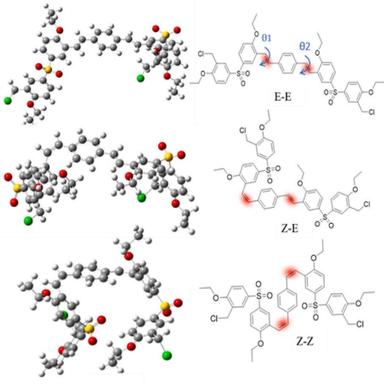
Optimized geometries of different stereoisomers of M-DSB molecule at the B3LYP/6-31G(d,p) level.